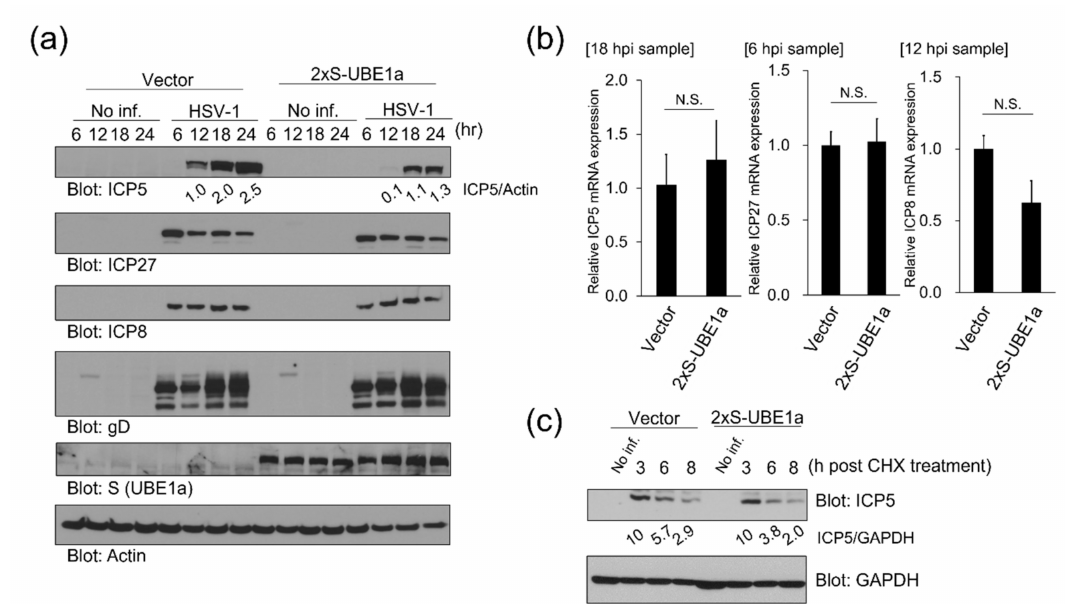
Figure 5. UBE1a overexpression reduced and retarded ICP5 protein expression. ( a ) UBE1a reduced and retarded ICP5 protein expression in HSV-1-infected cells. Polyclonal HeLa cell lines stably transfected with 2xS tagged UBE1a or empty vector were infected with HSV-1, and cells were harvested at 6–24 hpi. Cell lysates were analyzed by Western blotting, using anti-ICP5 (L gene product), ICP27 (IE gene